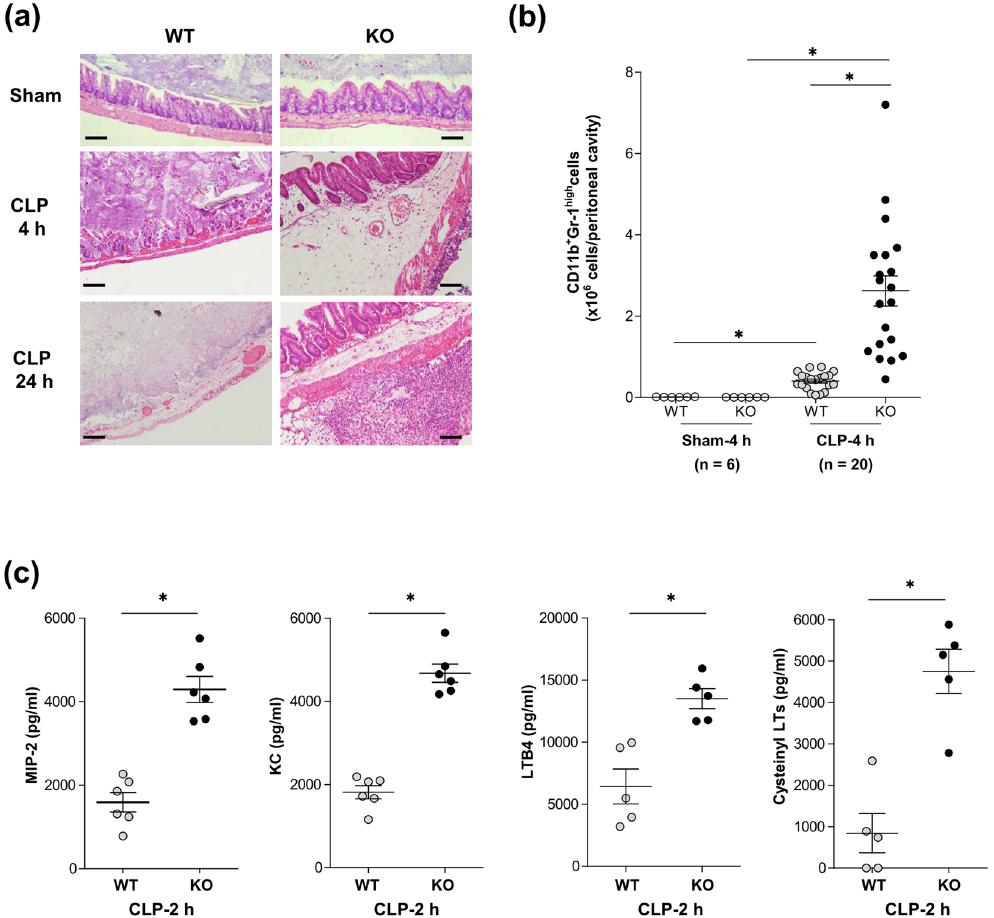
sections from WT or CD300f − / − mice at 4 h (top) after a sham operation and 4 h (middle) or 24 h (bottom) after CLP were stained with hematoxylin and eosin. Scale bars are 100 μ m. The data are representative of five